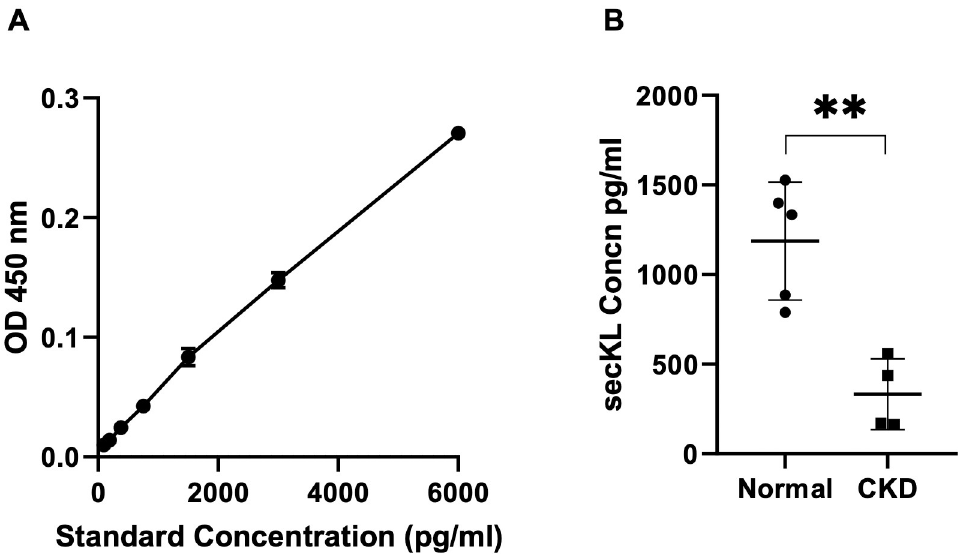
Fig 2. secKL protein levels are reduced in human plasma from CKD samples. (A) standard curve with secKL protein concentrations of 6000pg/ml, 3000pg/ml, 1500pg/ml, 750pg/ml, 375pg/ml, 187.5pg/ml, 93.75pg/ml (B) secKL protein levels in human plasma samples from normal (n = 5) Vs CKD (n = 4) (p < 0.003), confirmed that CKD is a state of Klotho deficiency. Two-tailed Student’s t test applied (error bars, +/- standard error of